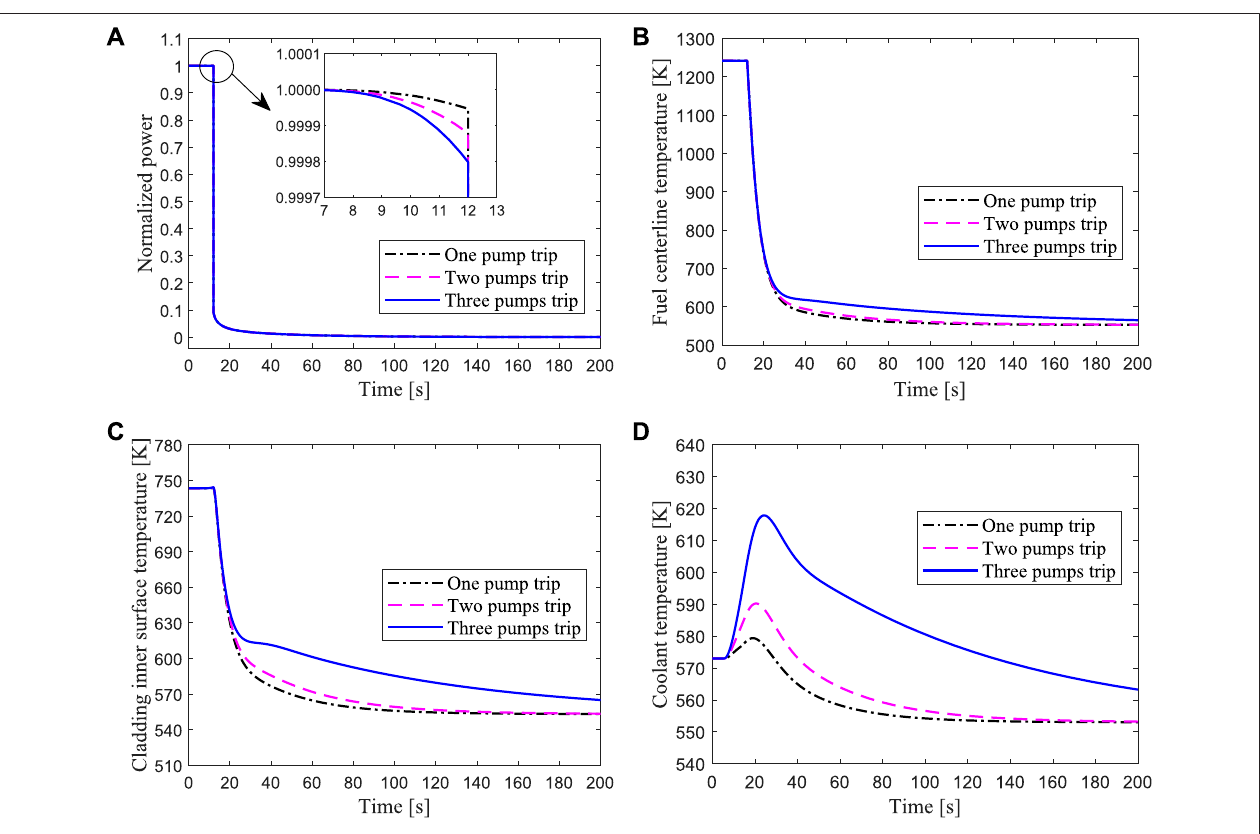
FIGURE 17 | Transient responses of the hottest channel for protected loss of heat sink due to one, two or three secondary pumps trip respectively.